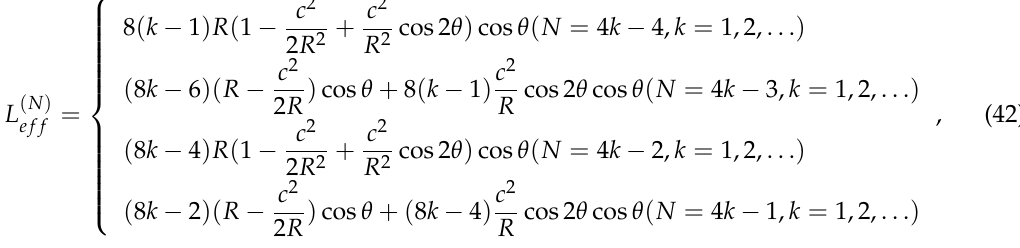
Figure 6. Constant interval adjustment of pass number in a cell with p = 14 and q = 5 by rotating around the axis of rotational symmetry (as indicated by blue rotation arrows) to change ϕ to: ( a ) ϕ 1 = π − 2 θ , corresponding to 27 passes; ( b ) ϕ 2 = π − 10 θ , corresponding to 23 passes; ( c ) ϕ 3 = π − 18 θ , corresponding to 19 passes; ( d ) ϕ 4 = π − 26 θ , corresponding to 15 passes within